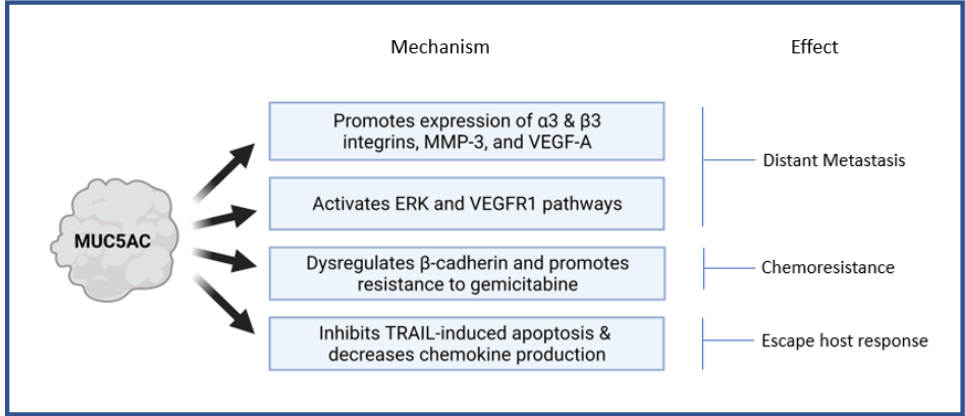
Figure 1. Pathophysiological mechanisms influenced by MUC5AC in pancreatic tissue. MMP-3 — matrix metalloproteinase; VEGF — Vascular endothelial growth factor; VEGFR — Vascular endothelial growth factor receptor; ERK — Extracellular-signal-regulated kinase; TRAIL — TNF-related apoptosis-inducing ligand.